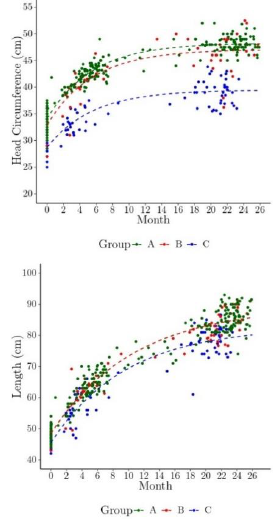
Figure 4. The model predicted marginal head circumference (HC) and length over time (shown here as dashed lines overlaid on the individual children’s observed HC and length measurements, by phenotype group). Children were usually measured three times approximately at birth, 1–7 months of age, and 24 months. Group phenotype: A = Zika-specific, B = nonspecific dysmorphic, and C = nondysmorphic.